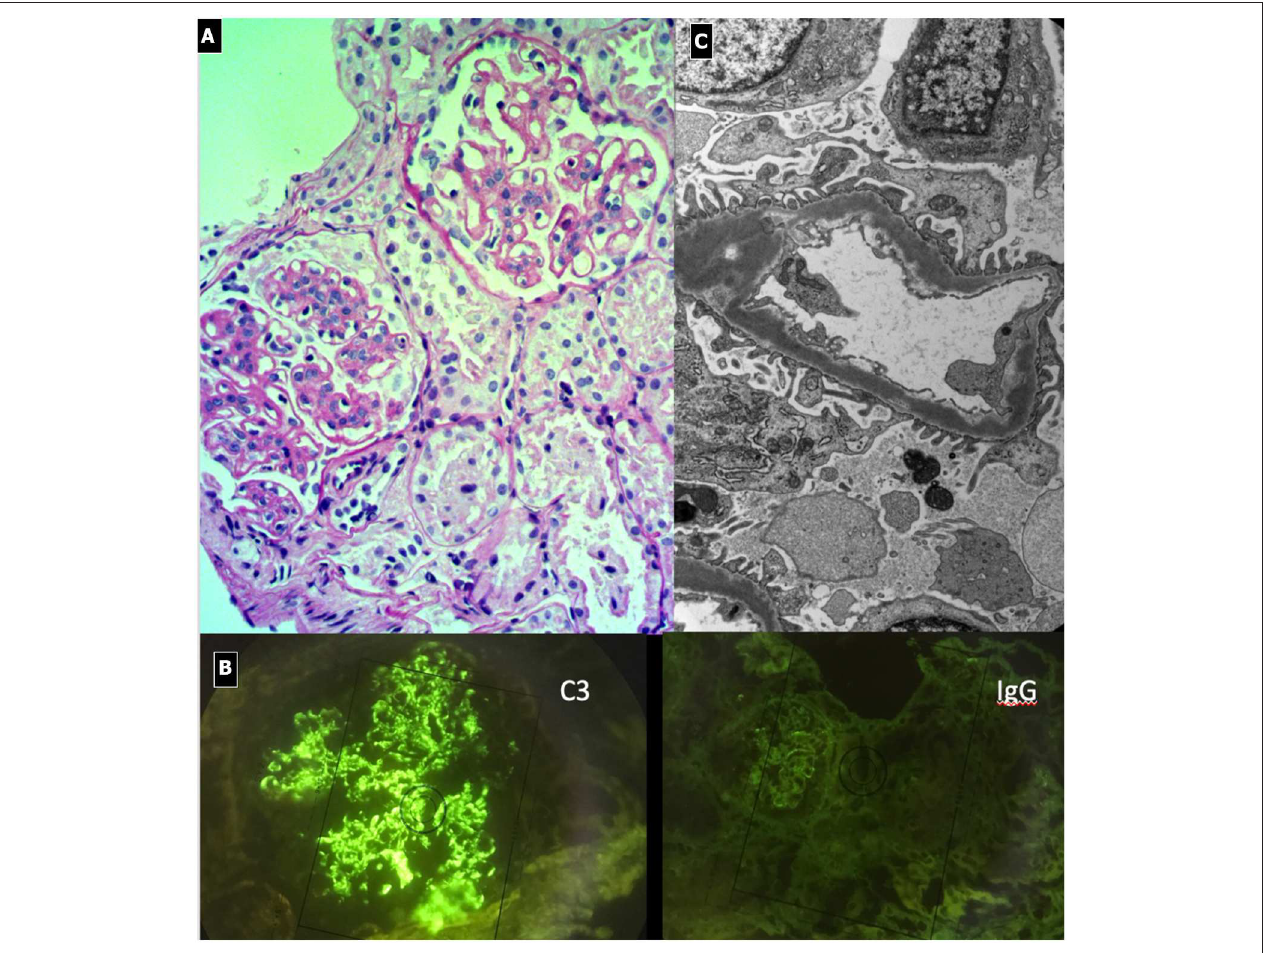
FIGURE 6 | Dense Deposit Disease. (A) LM (PAS stain): global thickening of GBM associated with lobular pattern. (B) IF shows isolated C3 positivity (mesangial/capillary wall distribution). (C) EM, typical electron-dense deposits along the entire course of the glomerular basement membrane (ribbon-like